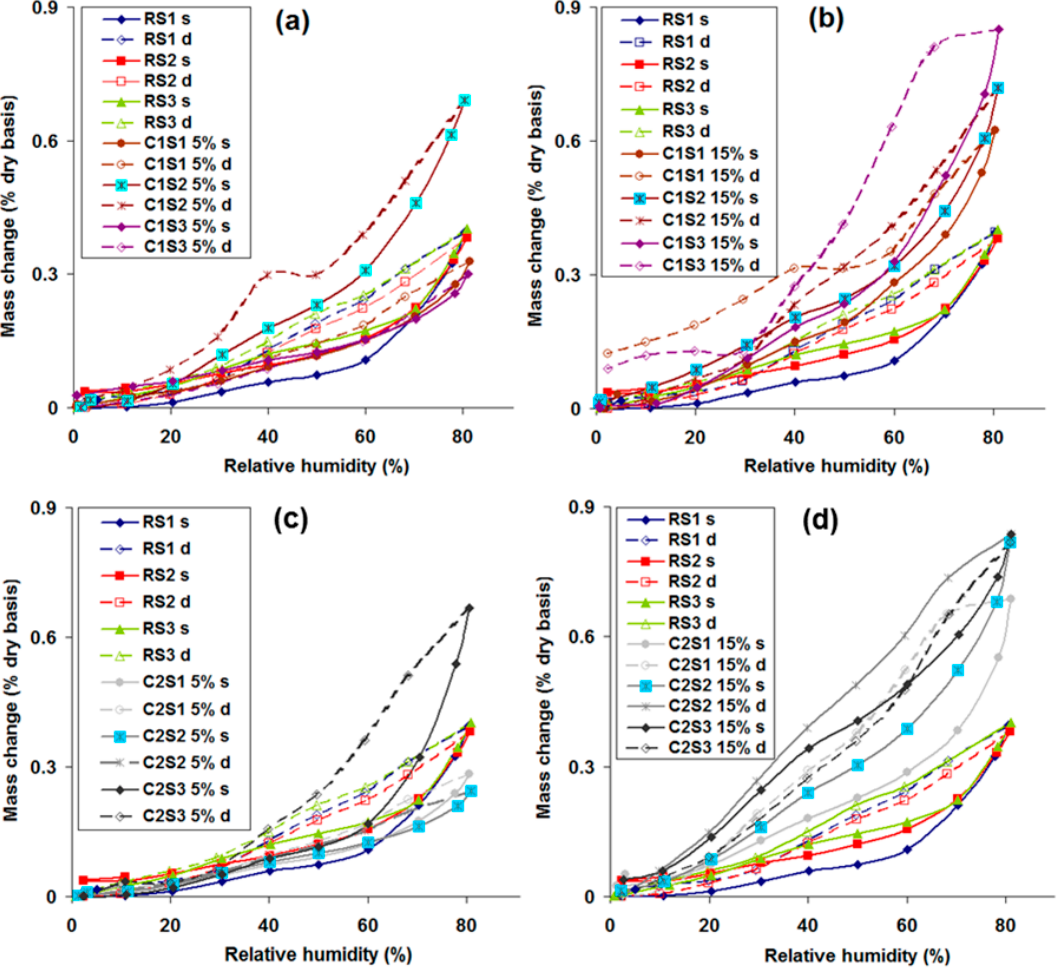
Figure 4. Dynamic vapor sorption of the samples: ( a ) with low content of complex C1 (5%); ( b ) with high content of complex C1 (15%); ( c ) with low content of complex C2 (5%); ( d ) with high content of complex C2 (15%).